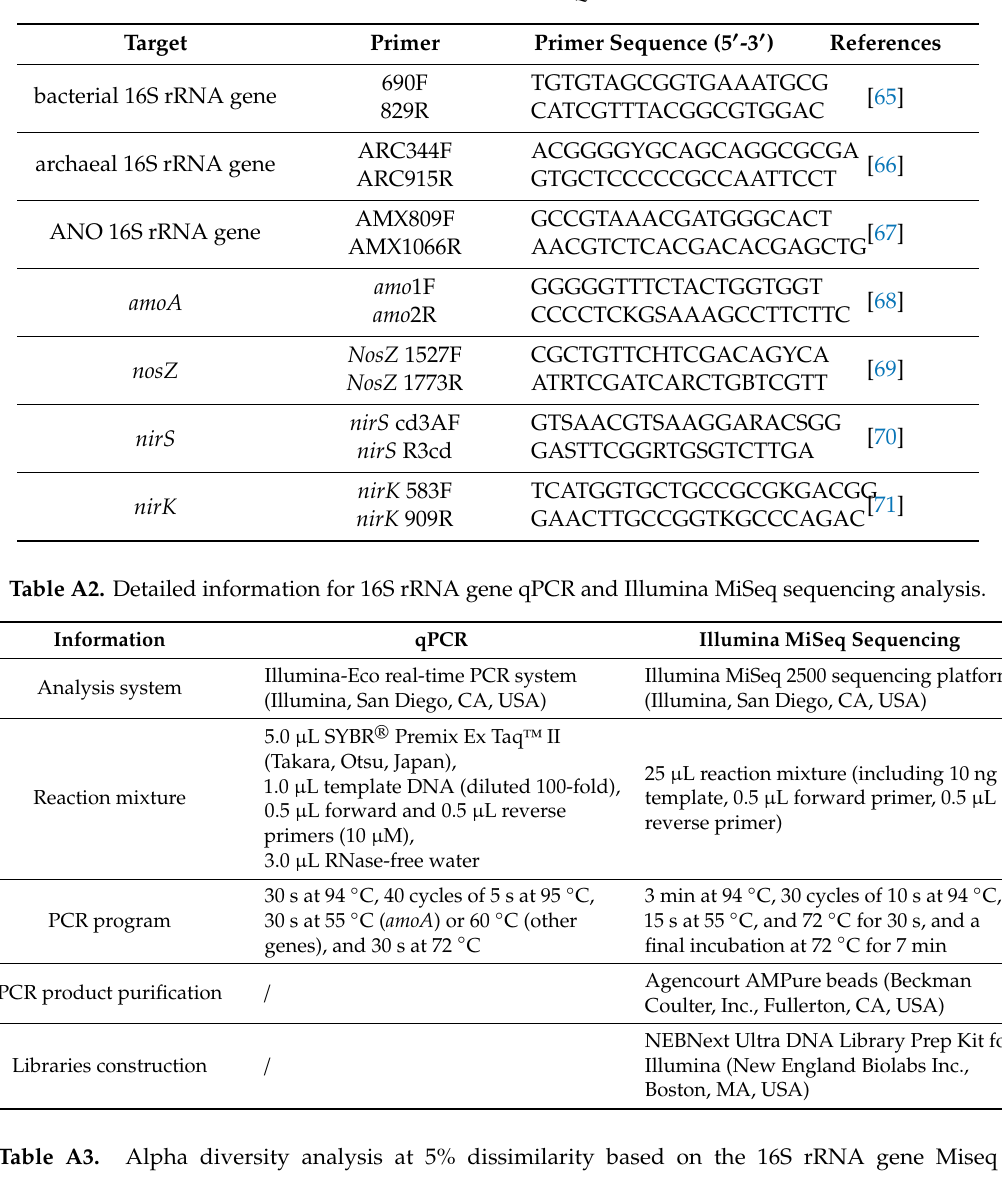
Table A1. Primers of QPCR.